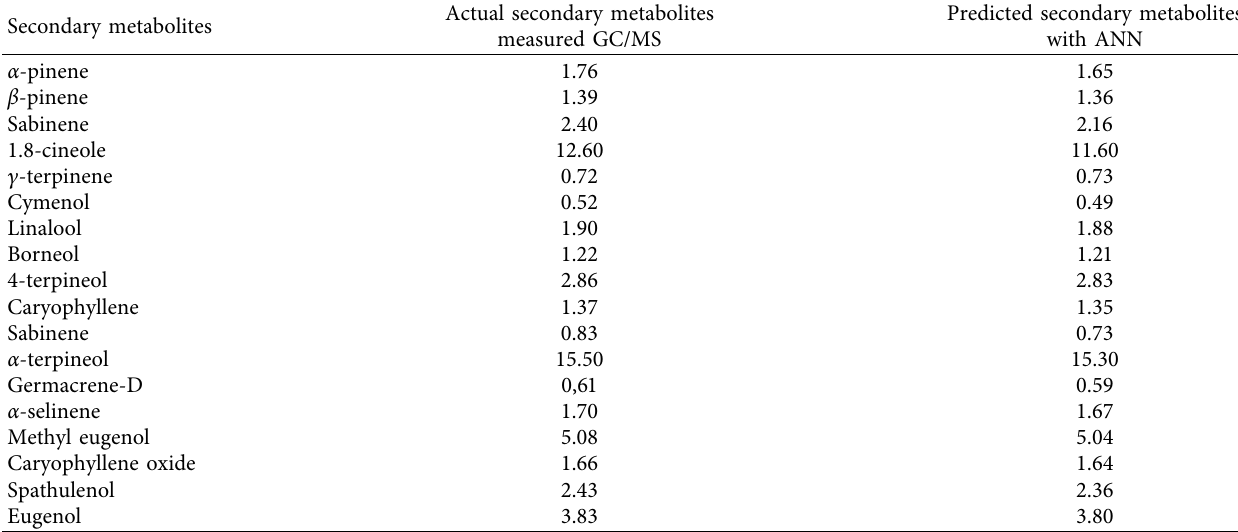
Table 3: Actual secondary metabolites measured GC/MS and predicted secondary metabolites with